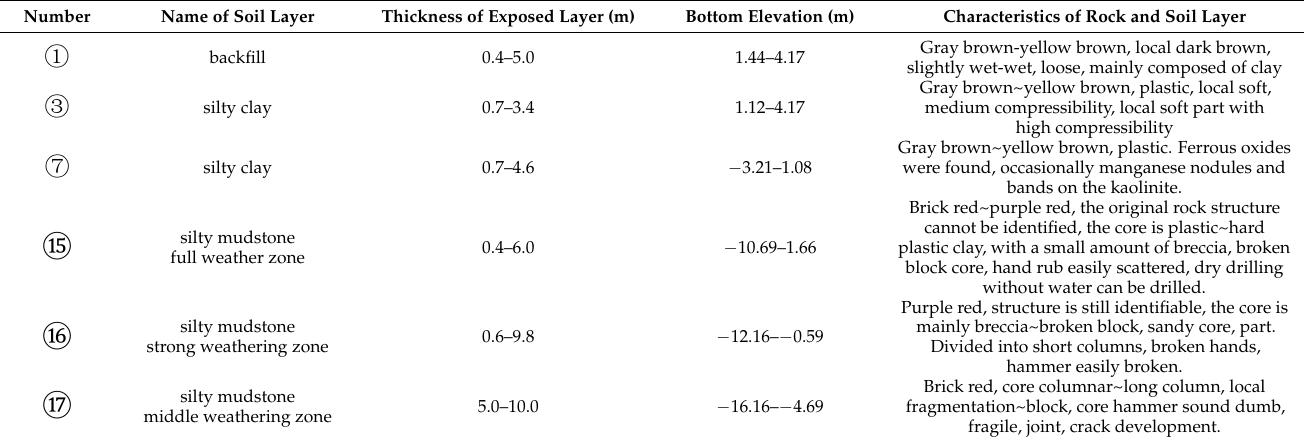
Table 1. Test site geotechnical distribution.